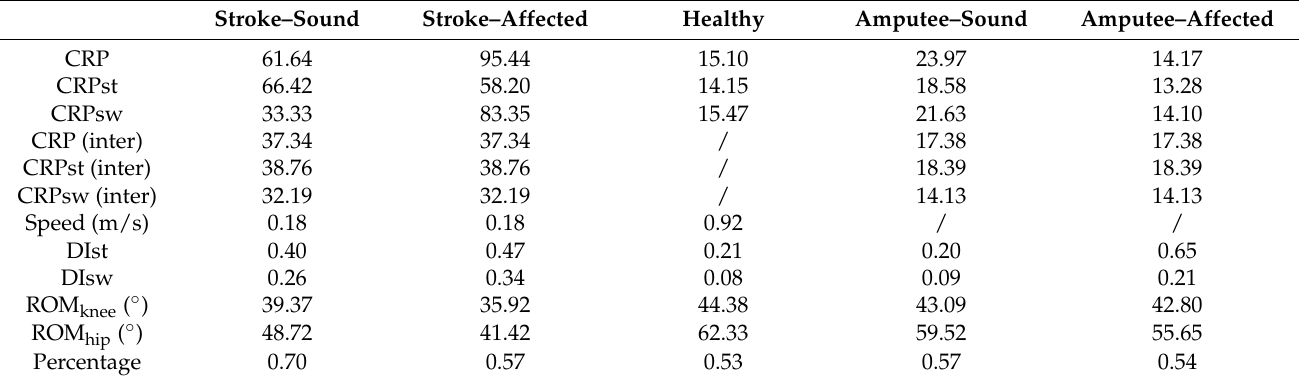
Table 2. Summary of gait data of different